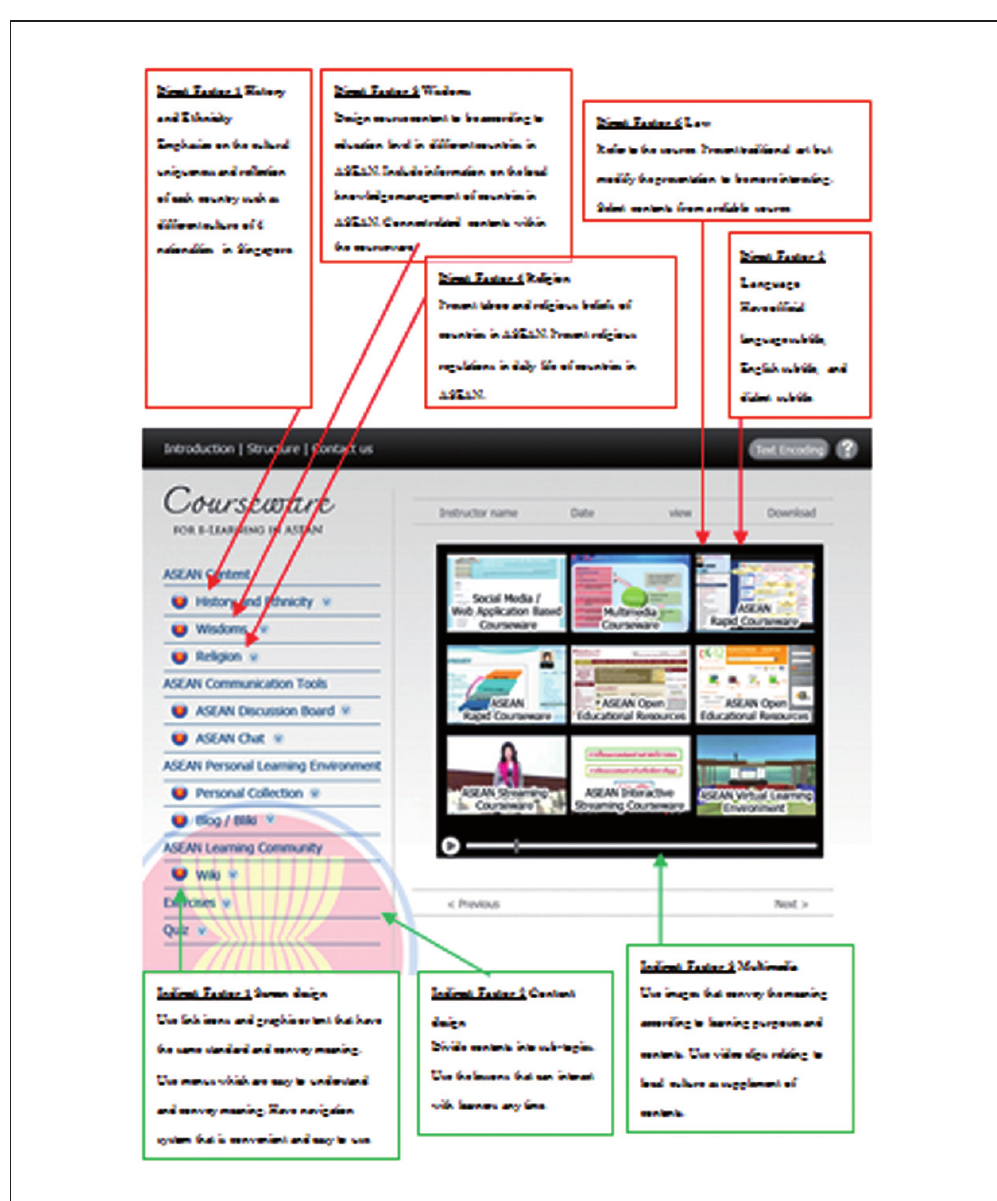
Picture 3 Proper Design Model of Courseware for e-Learning in